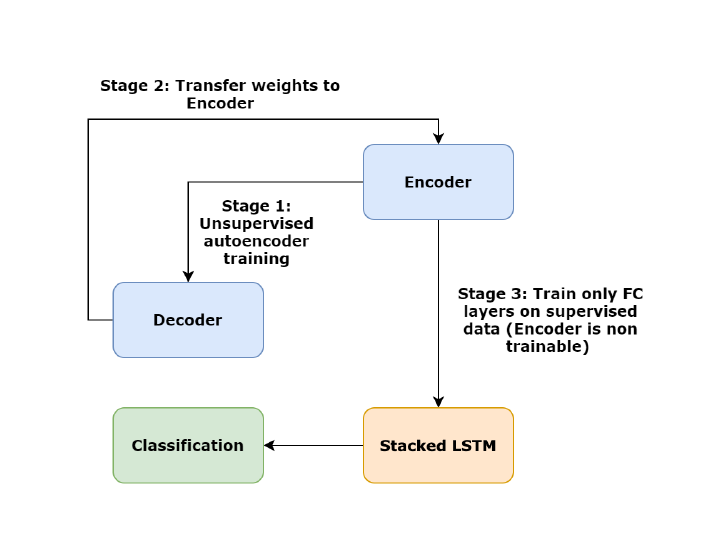
Figure 16. The three stage pipeline of the hybrid training procedure consists of an initial unsupervised training, followed by transfer learning and retraining of the stacked LSTM Classifier.